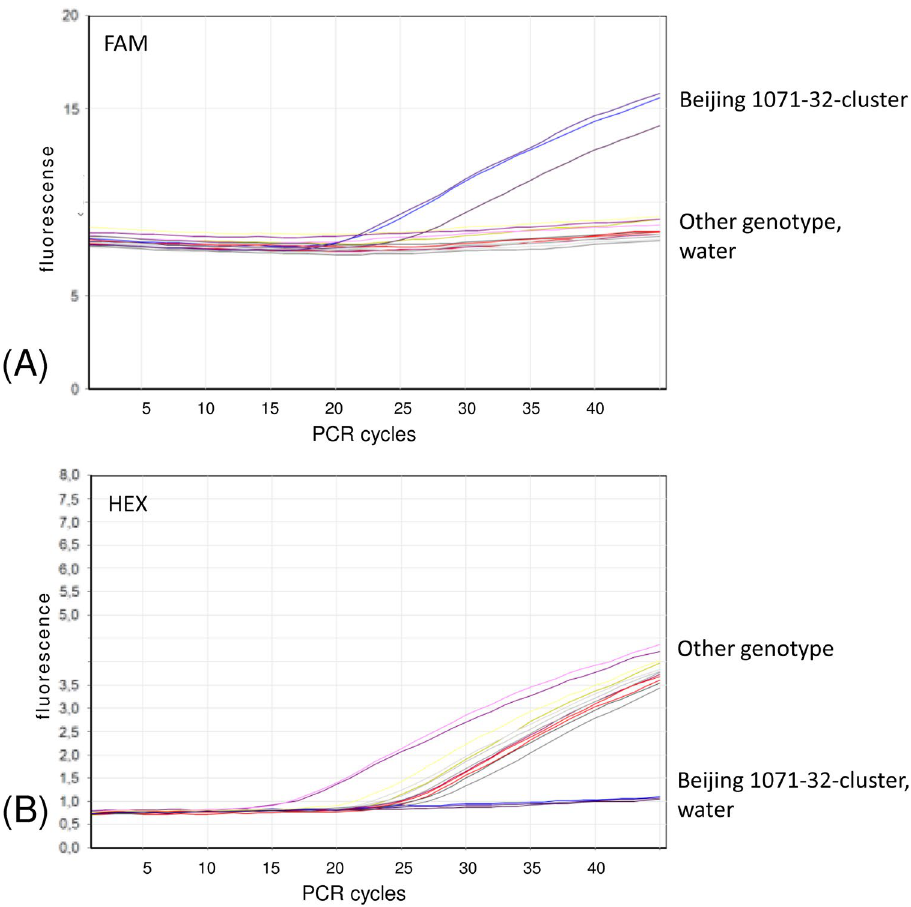
Figure 2. Fluorescence curves of a real-time PCR assay targeting Rv0144 SNP. ( A ) Beijing 1071-32 specific signal (FAM channel, 510 nm); ( B ) other genotype-specific signal (HEX channel, 555 nm). Water serves as negative control